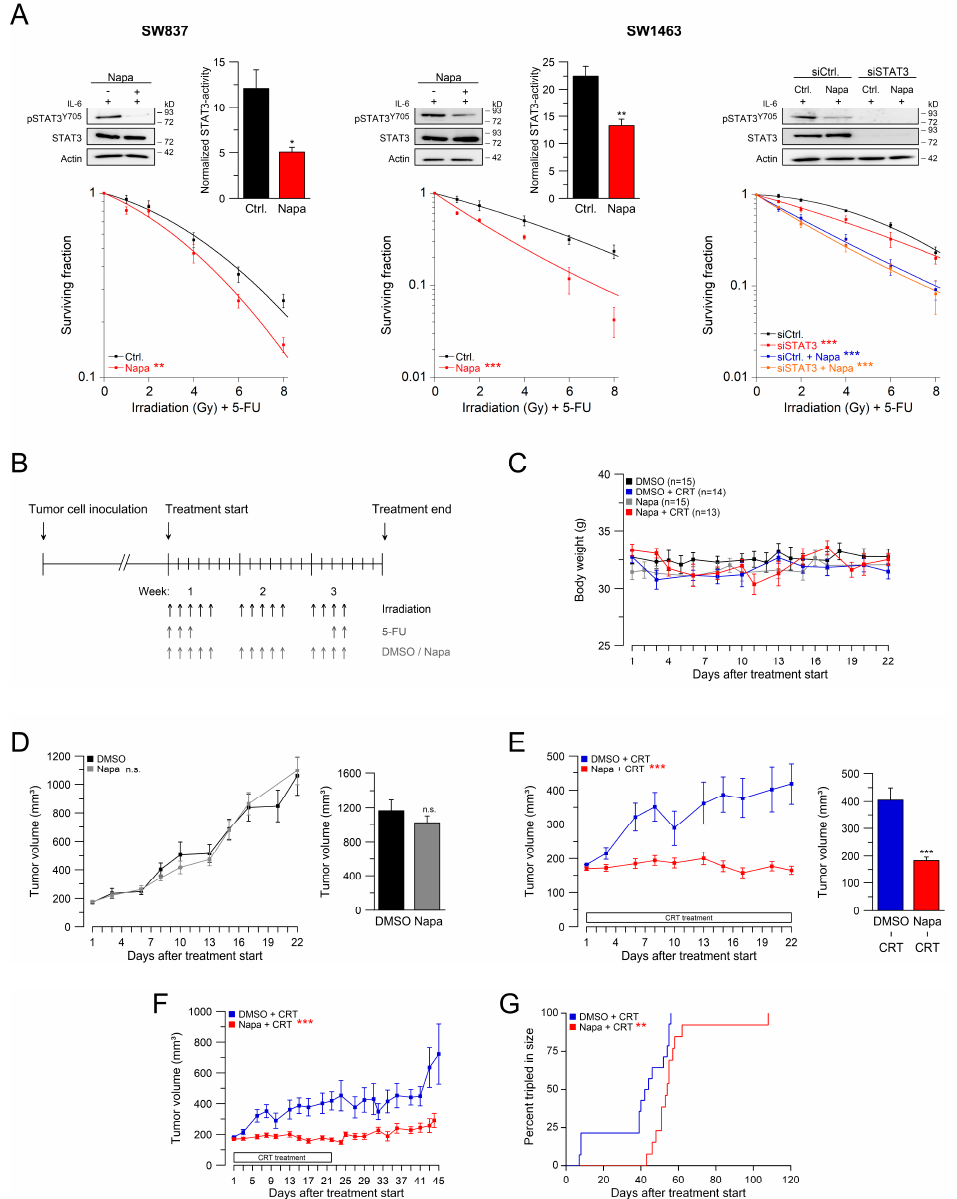
Figure 2. Targeting gp130/STAT3 signaling in vitro and in vivo. ( A ) SW837 or SW1463 cells were left untreated or treated with napabucasin (Napa) (left and middle panel) and analyzed for STAT3 functionality (upper graphs), or were monitored for CFA survival after CRT (lower graphs). Following siRNA-mediated STAT3 silencing and treatment with napabucasin, SW1463 cells or untreated control cells were subjected to STAT3 immunoblot analyses or CFA survival after CRT (right panel). Data presented as mean ± s.e.m. from at least n = 3 independent biological replicates. * p < 0.05, ** p < 0.01, *** p < 0.001, unpaired two-sample Student’s t-test or two-way analysis of variance (ANOVA). For p -values see Table S1. ( B ) Scheme of subcutaneous SW1463 rectal cancer xenograft model. ( C ) Body weight curves of mice treated with either DMSO ( n = 15), napabucasin ( n = 15), DMSO + CRT ( n = 14), or napabucasin + CRT ( n = 13). ( D , E ) Tumor volumes of mice during treatment (left panels), and at the end of treatment (right panels). Tumors were treated with DMSO or napabucasin, either without CRT ( D ) or with CRT ( E ). *** p < 0.0001 ( E , left panel), *** p = 6.668 × 10 − 5 ( E , right panel). ( F ) Tumor volumes of mice until day 45 after start of treatment, *** p < 0.0001. ( G ) Kaplan-Meier estimates of the time to tumor tripling. Median times to tumor tripling were 43 days (DMSO + CRT) and 54 days (napabucasin + CRT), ** p = 1.13 × 10 − 2 . p -values were calculated by mixed-effects analysis using Tukey’s multiple comparisons test ( D , E , left and F ), unpaired two-sample Student’s t -test ( D , E , right), or Log-rank (Mantel-Cox) test ( G ), see Table S1. Data points consisted of at least seven